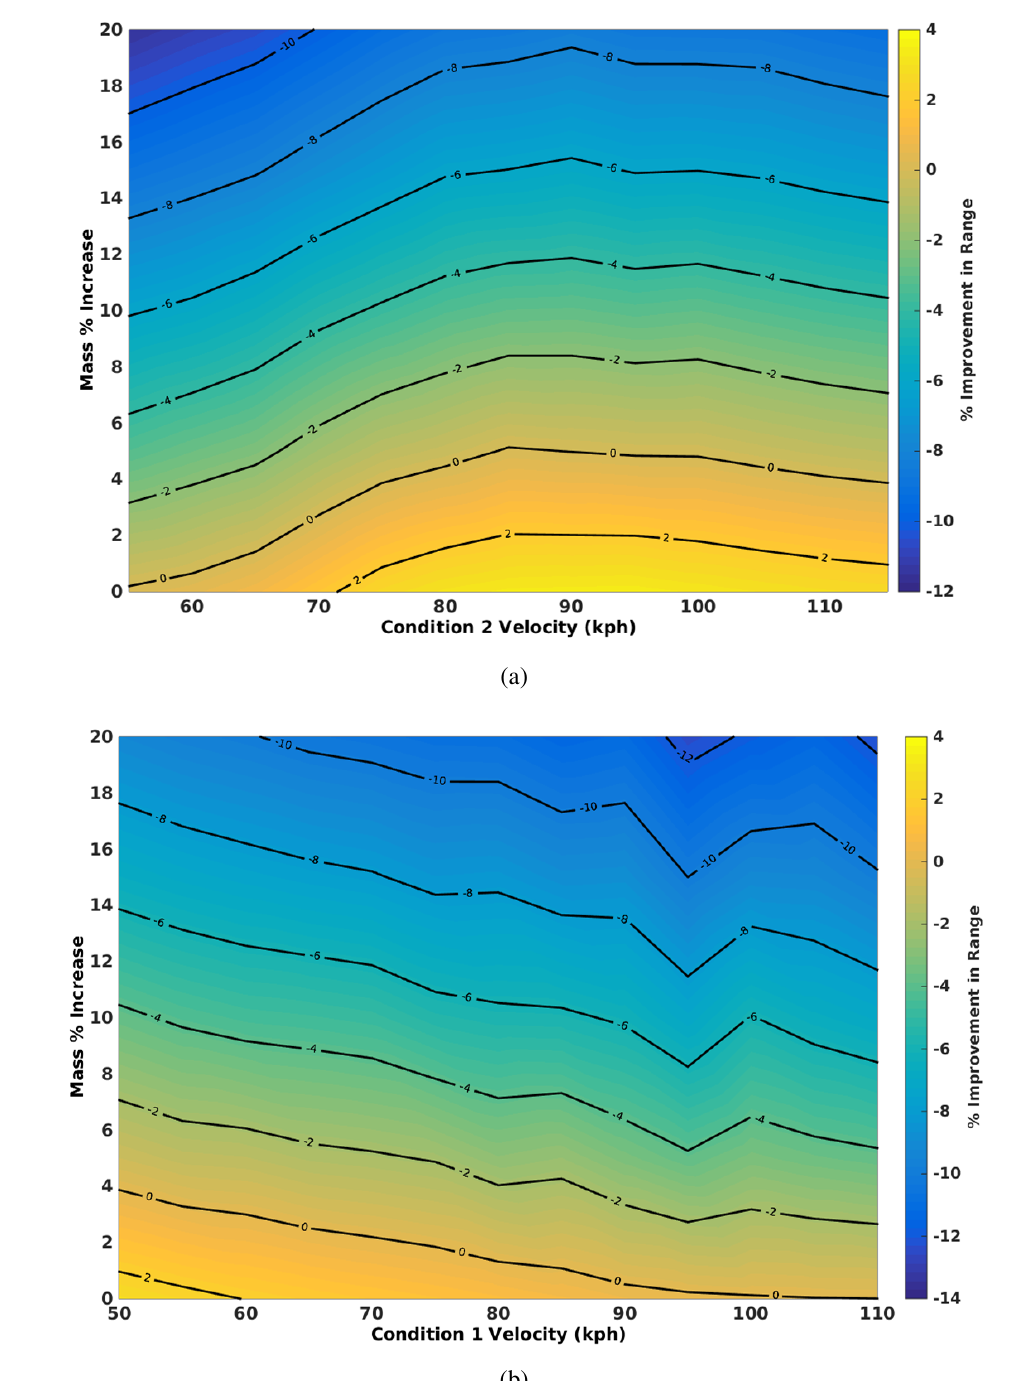
Figure 19. Effect of mass penalty on aerodynamic efficiency for optimum camber morphing design over variable speed ranges normalised to the baseline camber design. ( a ) Aerodynamic efficiency for low speed fixed at 50 kph; ( b ) aerodynamic efficiency for high speed fixed at 115